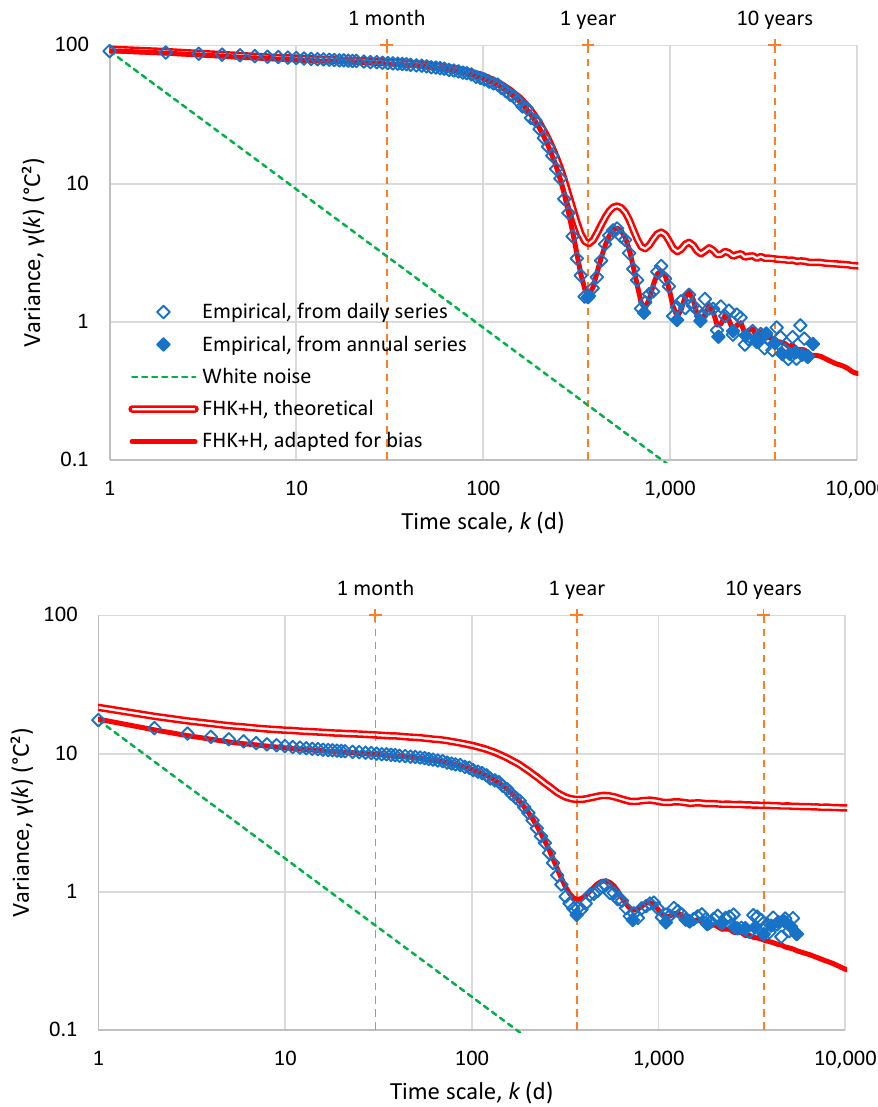
Figure A3. Climacograms of ( upper ) maximum daily temperature in Vienna and ( lower ) minimum daily temperature at Melbourne. FHK+H stands for filtered Hurst-Kolmogorov (FHK) process with an added harmonic oscillation (H). The climacogram of the FHK process and the harmonic have the mathematical expressions of Equations (7) and (10), respectively. The fitted parameters are for Vienna H = 0.95, M = 0.95, α = 1.50 d, λ 1 = 6.12 °C 2 , λ 2 = 20.31 °C 2 , λ T = 70.97 °C 2 and for Melbourne H = 0.98, M = 0.98, α = 0.38 d, λ 1 = 6.08 °C 2 , λ 2 = 15.91 °C 2 , λ T = 8.36 °C 2 .